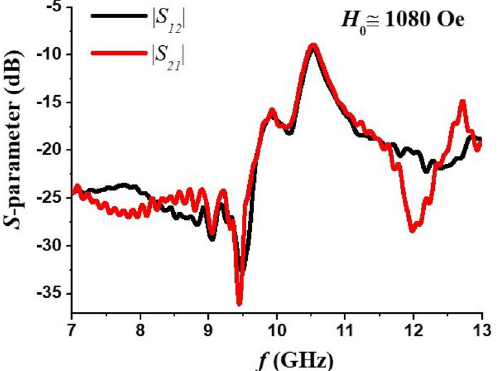
Figure 5. Profiles of transmission characteristics showing nonreciprocity for the filter. H 0 value was extracted from data in Fig.